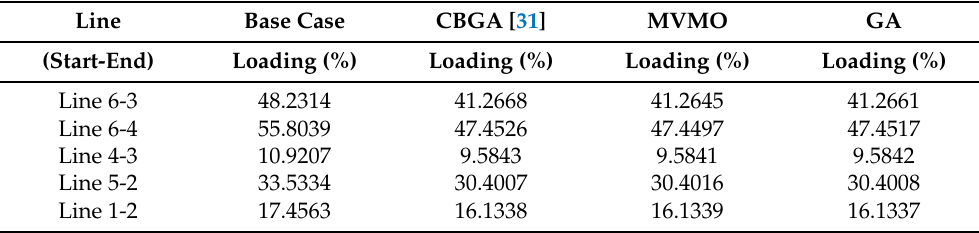
Table 9. Line loading for the IEEE 6-bus test system considering different approaches.